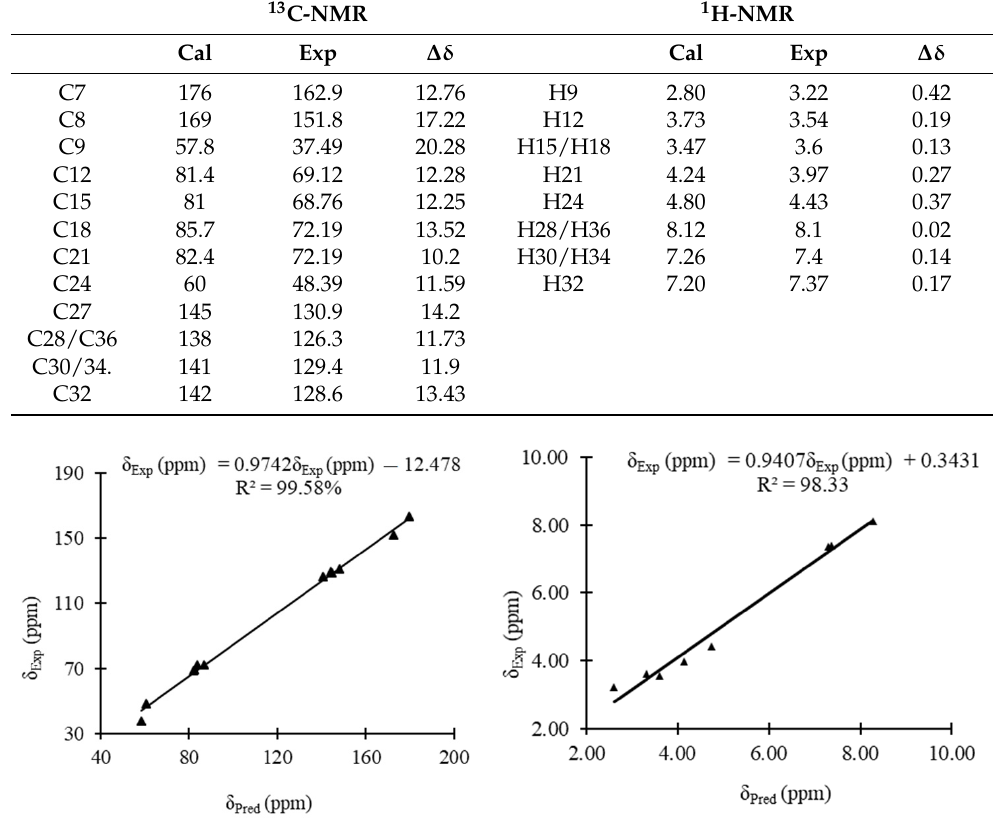
Figure 6. Linear correlation curves between the experimental 13 C and 1 H NMR chemical shifts of 3 and their corresponding predicted ones.